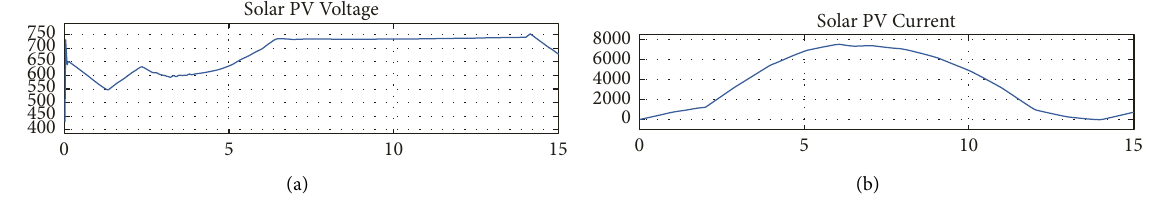
Figure 24: The I-V characteristics for the PO. Table 2: Analysis of the performance of proposed methods.